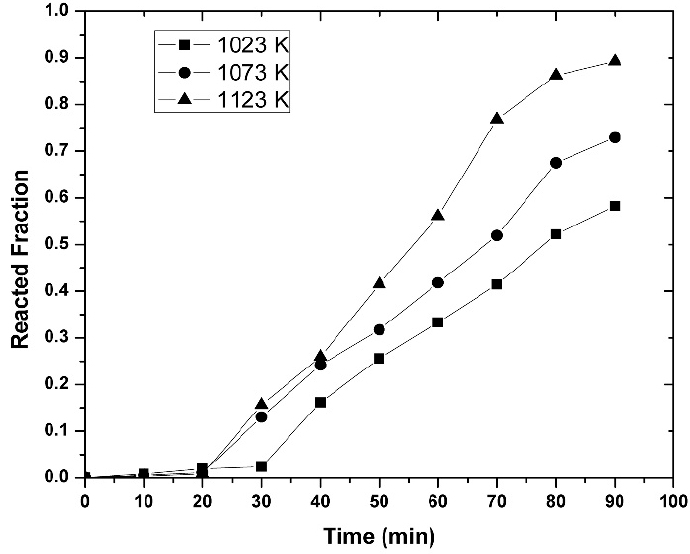
Figure 12. Reacted fraction of Ni as a function of time for the temperatures indicated, for a constant initial concentration of Mg of 3 wt-%, at the constant agitation speed of 300